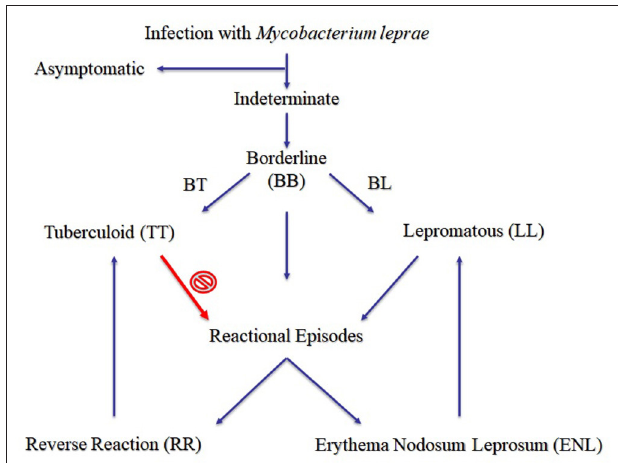
FIGURE 1 | Proposed clinical forms of leprosy